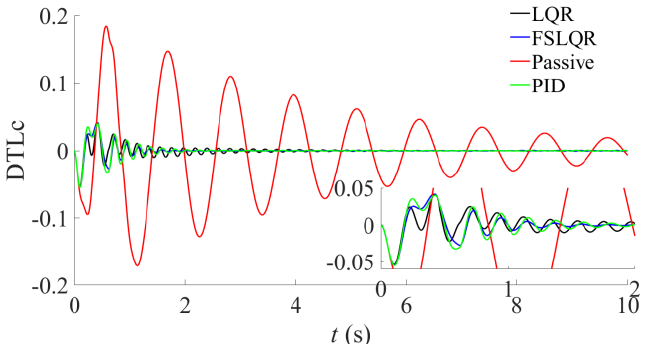
Figure 4. The tire ’ s loading coefficient responses of DTLc under the impulse excitation.